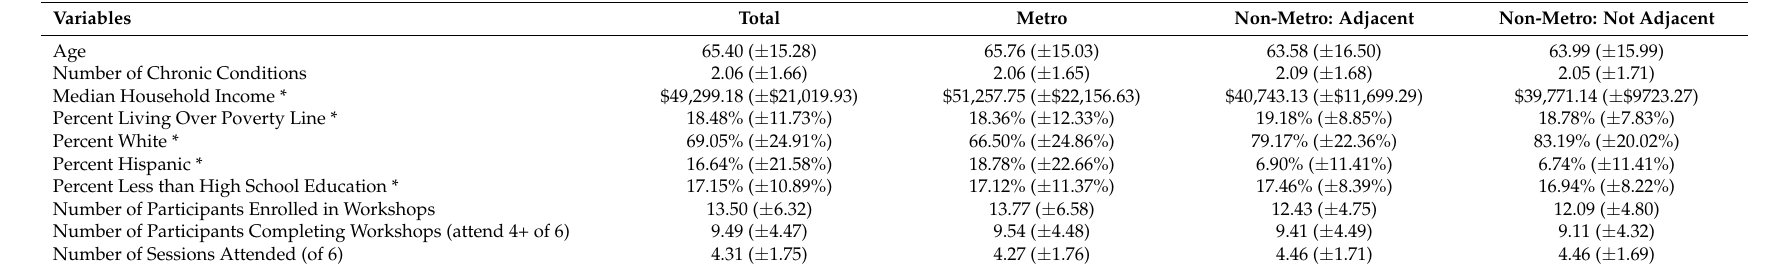
* Indicates statistic from the ZIP Code Tabulation Area (ZCTA) of the delivery site